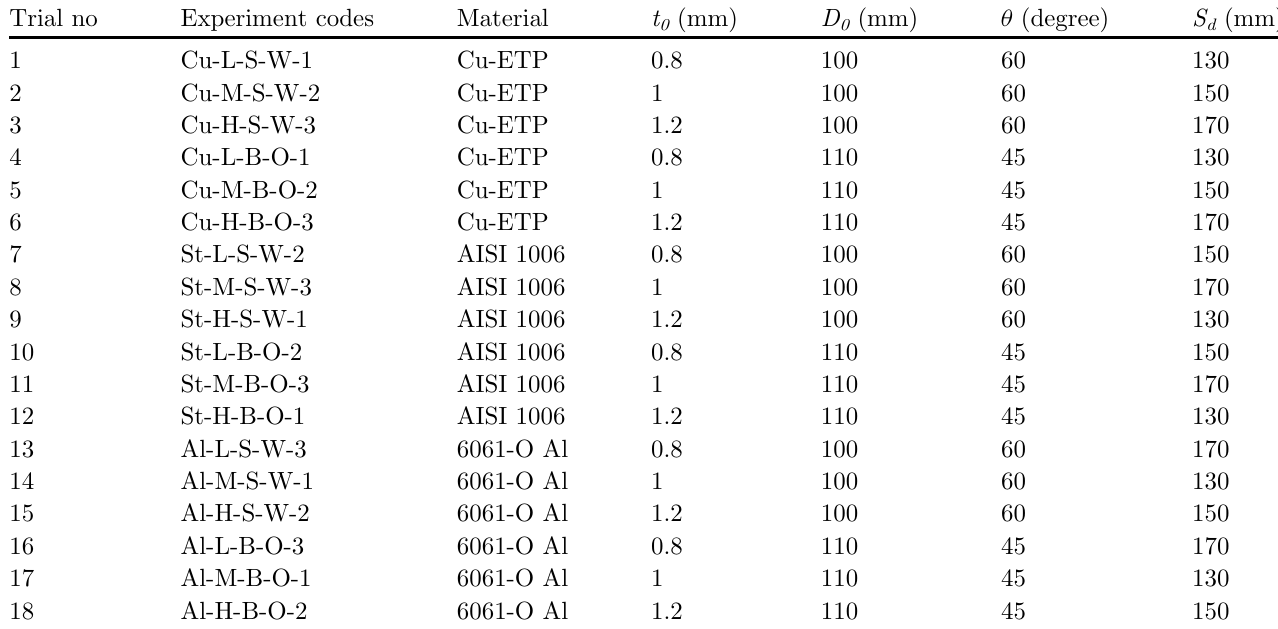
Table 2. Experimental plan and